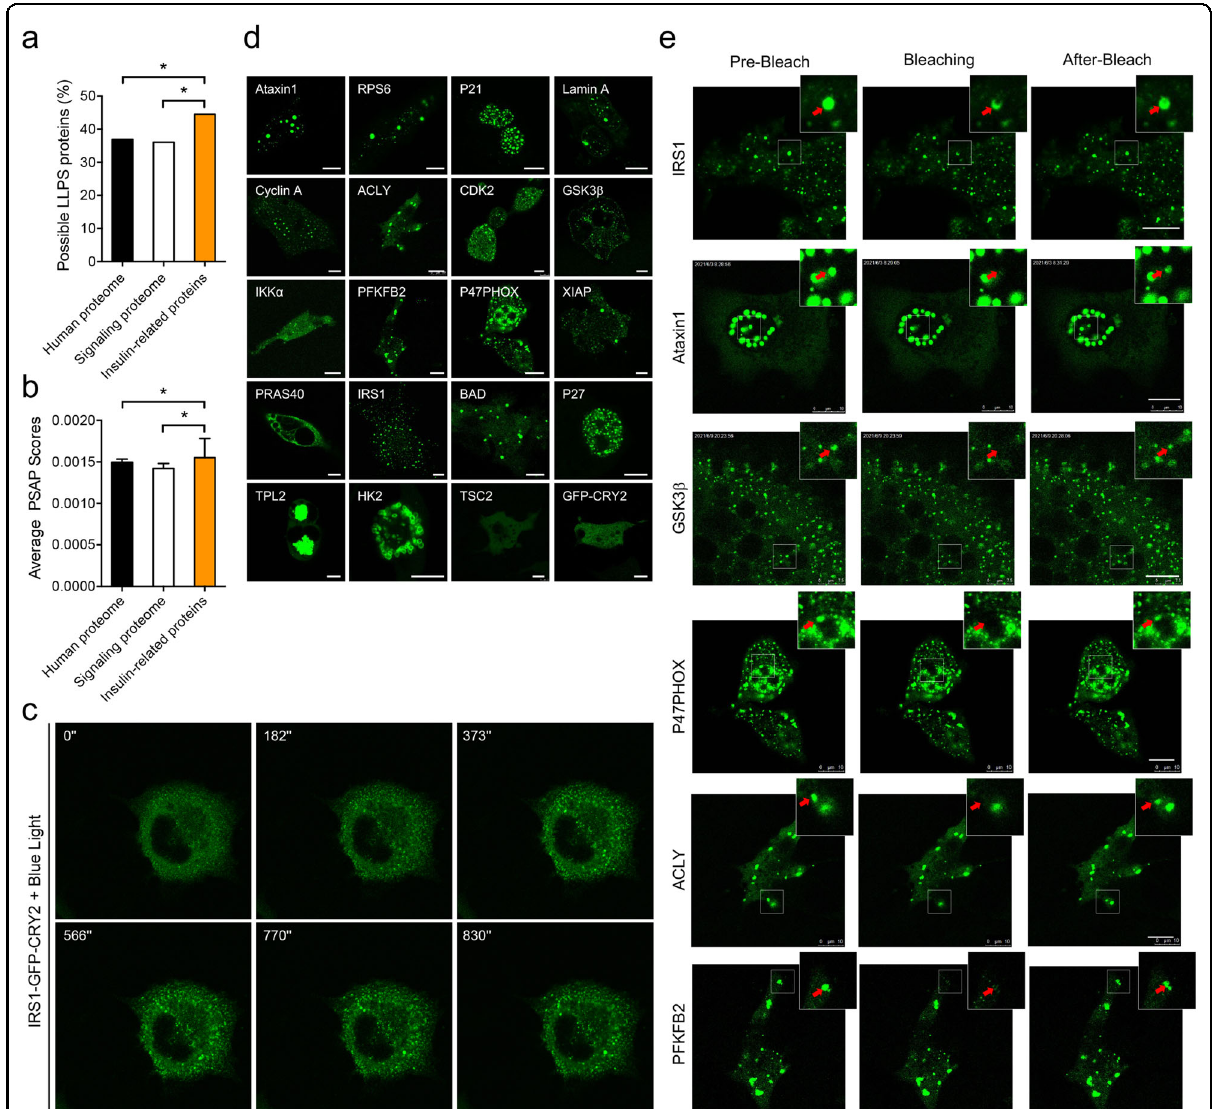
Fig. 1 LLPS potential of insulin-related proteins. a , b LLPS scores of human proteome, signaling transduction proteome and insulin-related proteins. The predictor PSAP was used to calculate LLPS scores. The percentage of proteins with LLPS feature ( a ) and average store ( b ) were presented in the 3 groups. n = 17,817 (human proteome), 5520 (signaling transduction proteome), and 173 (insulin-related proteins). The data are given as percentage ( a ) and the means ± SEM ( b ). Statistical analyses were carried out using Fisher ’ s Exact test ( a ) and Mann – Whitney U test ( b ). * p < 0.05. c Time-series imaging of IRS1-GFP-CRY2 (optoIRS1) upon induction with blue light in Cos-7 cells. Scale bar, 10 μ m. d Blue light induced formation of optoDroplets of insulin-related proteins in Cos-7 cells. Scale bar, 10 μ m. e FRAP analysis of optoDroplets of insulin-related proteins in Cos-7 cells. The optoDroplets subjected to FRAP analysis were highlighted in insets. Scale bar, 10 μ